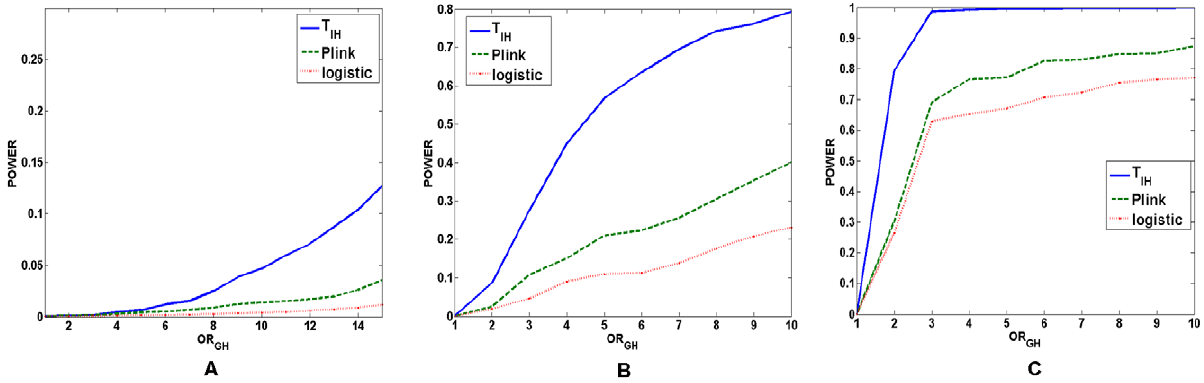
Figure 5. Power of the statistics for testing interaction between two unlinked loci. (A) The power of the test statistic T IH , the ‘‘fast- epistasis’’ in PLINK and logistic regression analysis for testing interaction between two unlinked loci as a function of traditional odds-ratio OR GH under a two-locus recessive | recessive disease model, where the number of individuals in both the case and control groups is 2,000, the significance level is 0.001, and the odds-ratios at two loci were OR G ~ OR H ~ 1 . (B) The power of the test statistic T IH , the ‘‘fast-epistasis’’ in PLINK and logistic regression analysis for testing interaction between two unlinked loci as a function of traditional odds-ratio OR GH under a two-locus dominant | dominant disease model, where the number of individuals in both the case and control groups is 1,000, the significance level is 0.001, and the odds-ratios at two loci were OR G ~ OR H ~ 1 . (C) The power of the test statistic T IH , the ‘‘fast-epistasis’’ in PLINK and logistic regression analysis for testing interaction between two unlinked loci as a function of traditional odds-ratio OR GH under a two-locus additive | additive disease model, where the number of individuals in both the case and control groups is 1,000, the significance level is 0.001, and the odds-ratios at two loci were OR G ~ OR H ~ 1 .